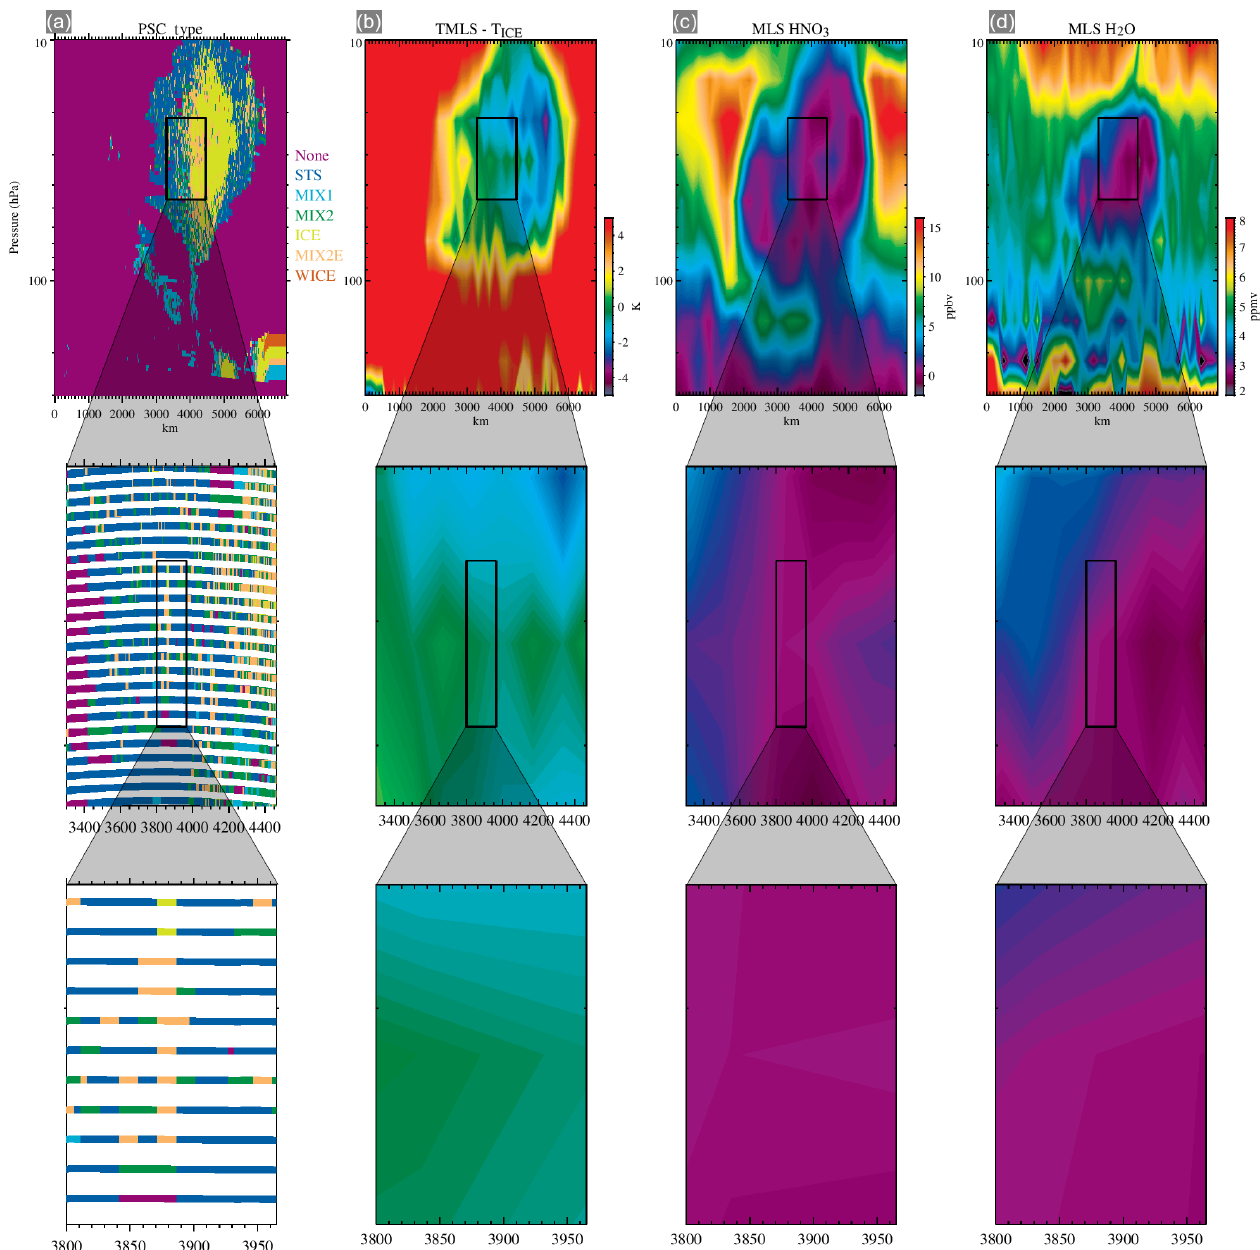
Figure 9. Along-track vertical cross sections of PSCs, temperature, HNO 3 , and H 2 O over a 7000km transect crossing Antarctica on 23 June 2008 (2008d175). (a) CALIOP PSC types. (b) MLS temperature relative to the ice frost point. (c) MLS HNO 3 . (d) MLS H 2 O. Selected regions (black rectangular boxes), centered at 32hPa in the top row, are shown enlarged in the middle row (1165km along track by 4.32km high), and similarly enlarged again in the bottom row (165km by 2.16km). In the bottom row, the resolution is that of the MLS geometric FOV, in which MLS reports only a single measurement value, whereas CALIOP reports ∼ 400 individual 5km by 0.180km